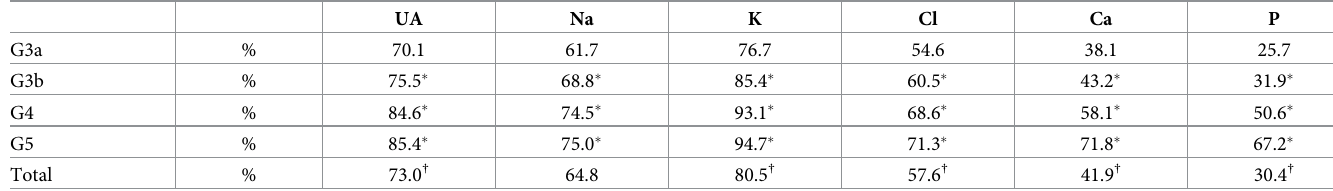
Table 1. Sampling rate stratification according to G category